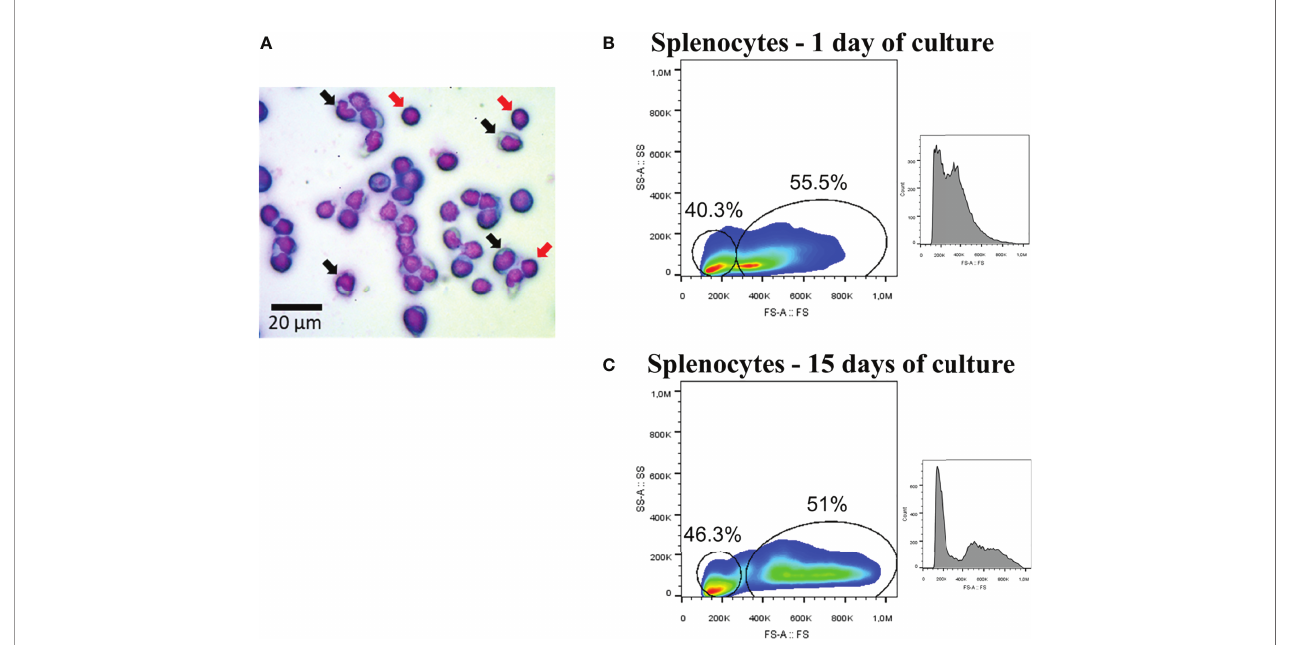
FIGURE 1 | Splenocytes of Atlantic salmon. (A) Mononuclear fraction. Black arrows showed cells with morphology associated with monocytes, while red arrows showed examples of cells with lymphocyte-associated morphology. The image was taken with magni fi cation 400×. (B) Flow cytometry (FS-A/SSC-A and histogram/ FS-A) using splenocytes at 1 day of culture. (C) Flow cytometry (FS-A/SSC-A and histogram/FS-A) using splenocytes at 15 day of